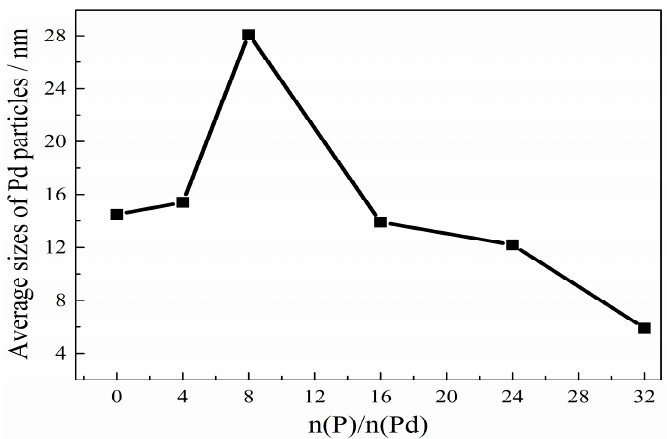
Figure 3. Transmission electron microscopy (TEM) images of Pd-P/C catalysts treated with different addition amounts of hypophosphite and PdO/C. ( a ) PdO/C; ( b ) Pd-P(0)/C(400); ( c ) Pd-P(8)/C(400); ( d ) Pd-P(32)/C(400); ( e ) element line scan of Pd and P of Pd-P(32)/C(400).